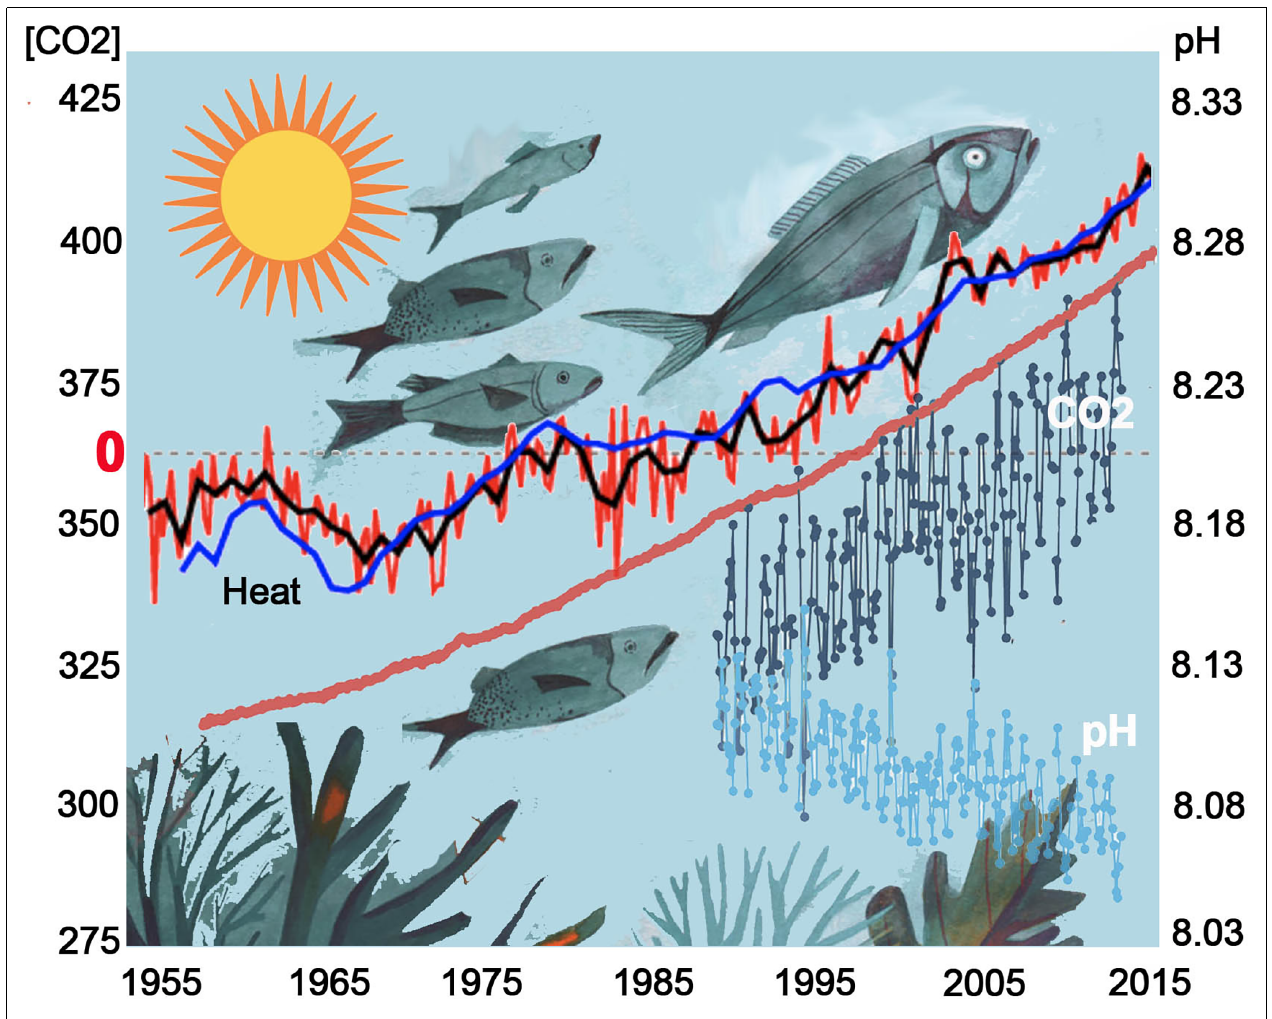
FIGURE 3 | Ocean heating and increasing CO 2 concentration affect fish behaviors. As the oceans heat up (Heat), marine species are moving deeper in the water column and towards the poles to escape rising temperature (Heat, increases since 1955 over average dotted line; https://www.ncei.noaa.gov/access/global-ocean-heat-content/#null). Concomitant increases in CO 2 in the atmosphere (red), and oceans (gray), are driving the pH acidic (blue) thus affecting olfactory-mediated behaviors in marine animals.